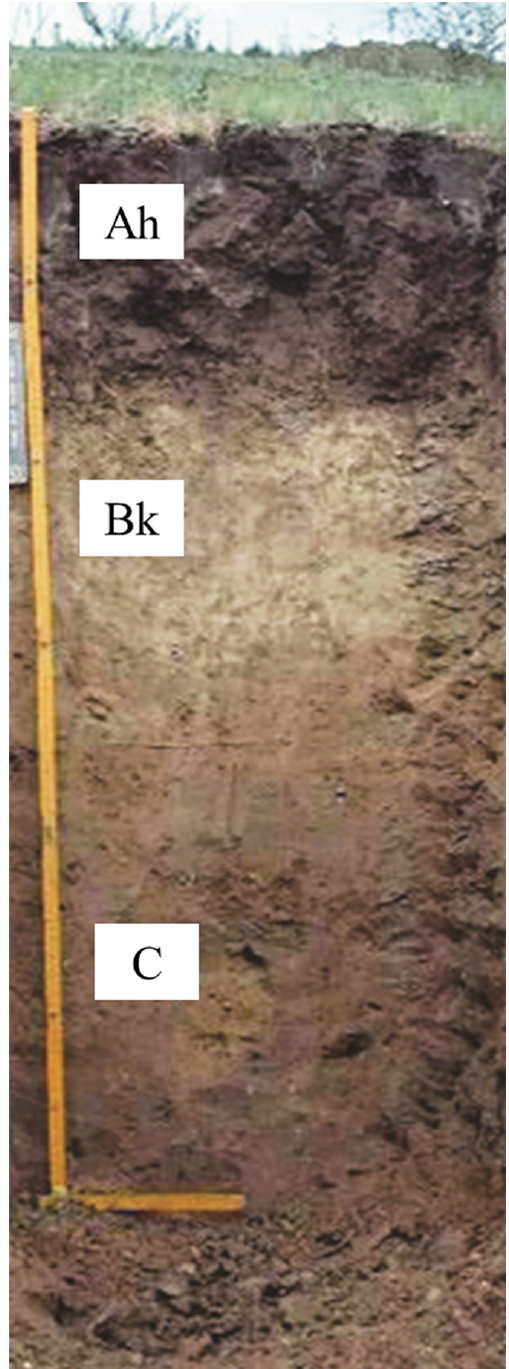
Figure 1. Schematic diagram of chestnut soil illustrating three soil horizons (figure modified from the Digital Science and Technology Museum of China, http://amuseum.cdstm.cn/AMuseum/agricul/6_